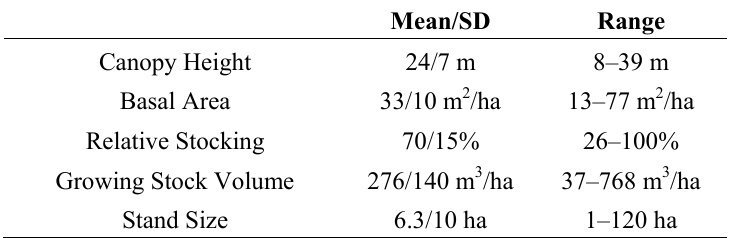
Table 1. Biophysical properties of 424 Pinus radiata stands in the study